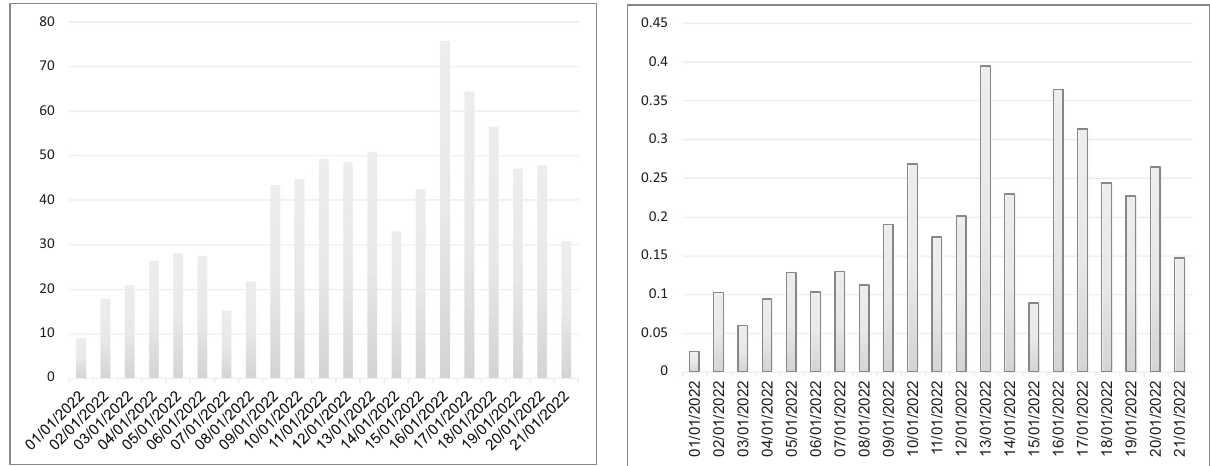
Fig. 1 Daily SARS-Cov-2 infection and SARS-Cov-2-related hospitalization rates per 10,000 persons. The graph exempli fi es Omicron ’ s spread, with a rapid increase in infections and hospitalizations, peaking in mid-January.